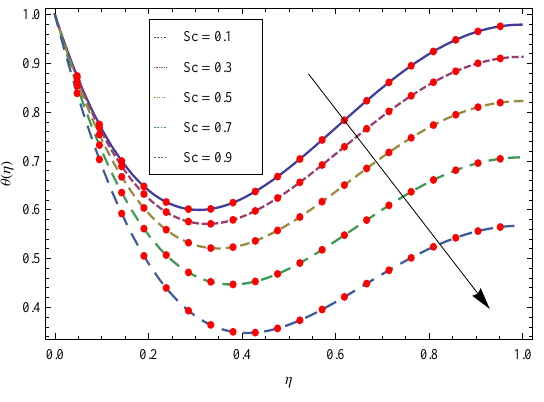
Figure 14. Shows the effect of Pr on θ ( η ) for h = − 0.7, λ = 0.7, S = 0.7,kr = 0.1,Ec = 0.5, Nb = 0.5, Nt = 0.2, β = 1 and Sc = 0.2.